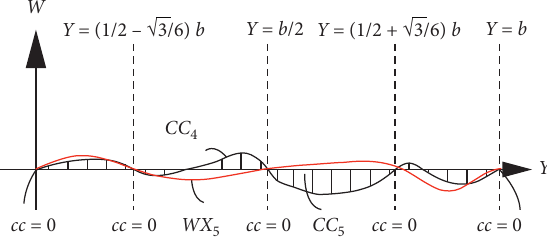
Figure 9: The fifth interpolation function on the plane ( Y, Z ) .